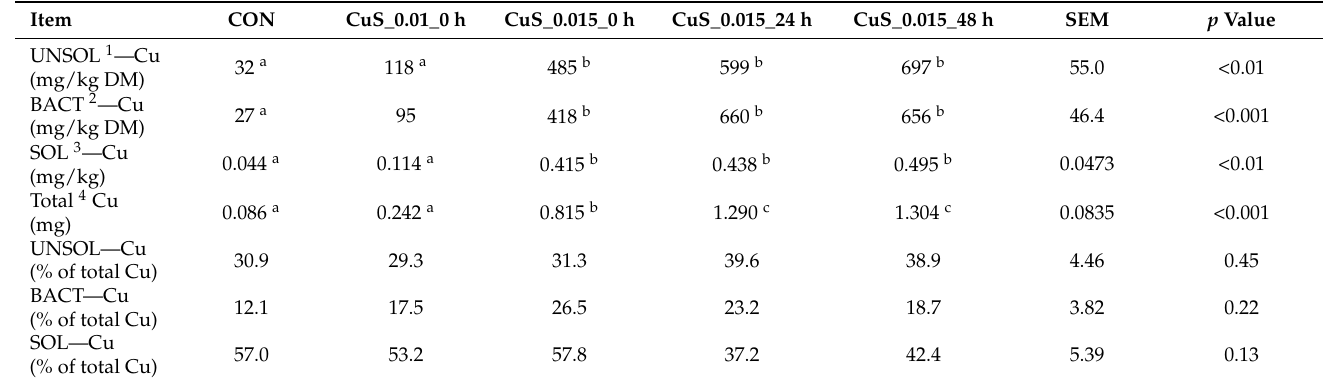
Table 8. Influence of CuSO 4 dose and addition time on solubility